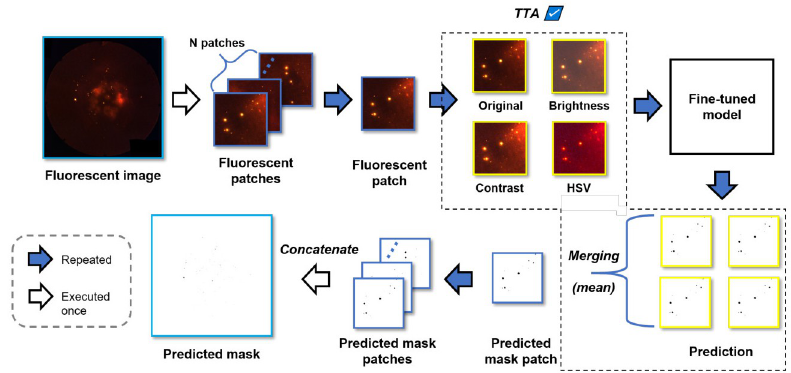
Fig 7. Mask generation for the fluorescence images in the set used for testing. The generated masks are compared with the ground truth masks to evaluate the effectiveness of a model, hereby using different metrics. When TTA is not implemented, the predicted mask patches are generated directly from the fluorescence patches. In contrast, when TTA is implemented (depicted with a dotted box), the fluorescence patches are augmented and the masks obtained for these patches are merged into a single mask by taking the pixel-wise average of each